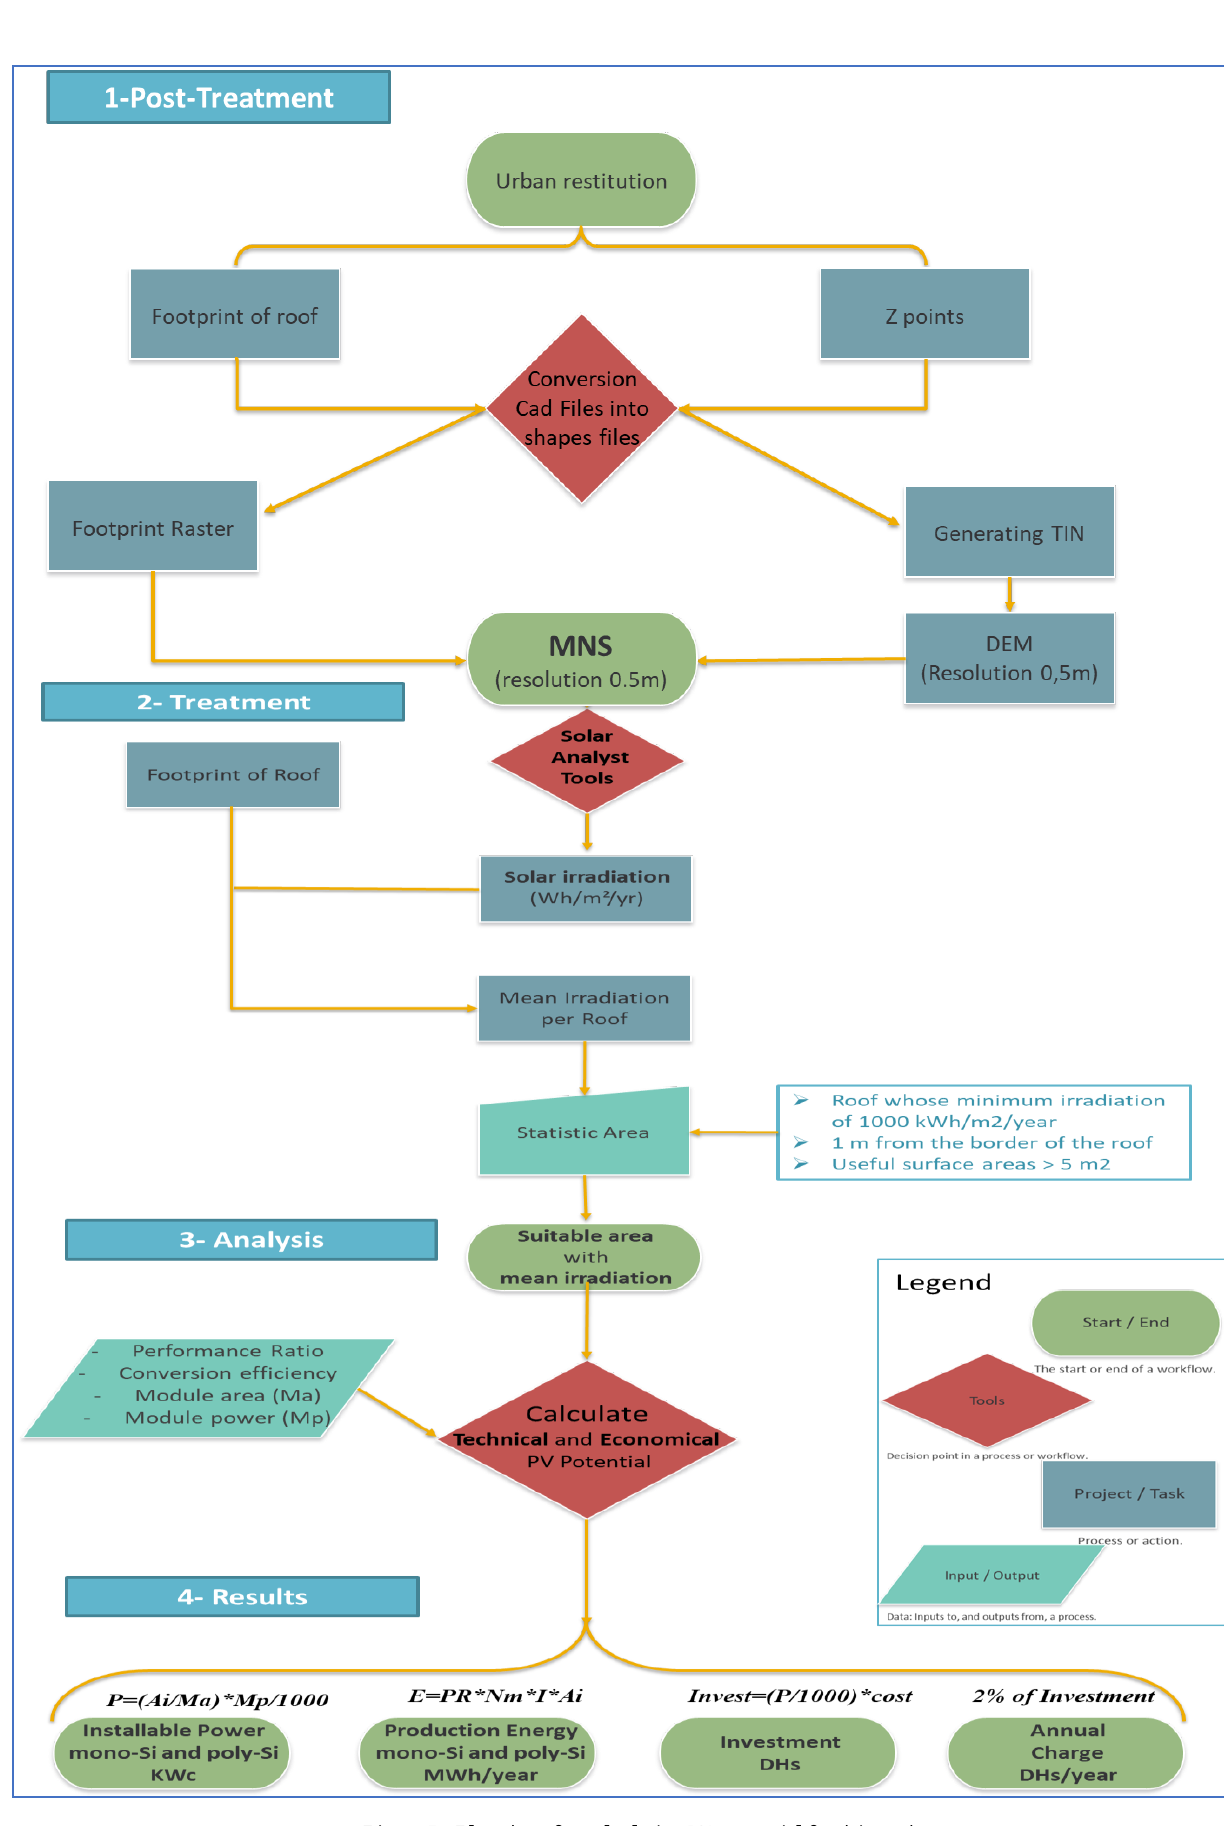
Figure 5. Flowchart for calculating PV potential for this